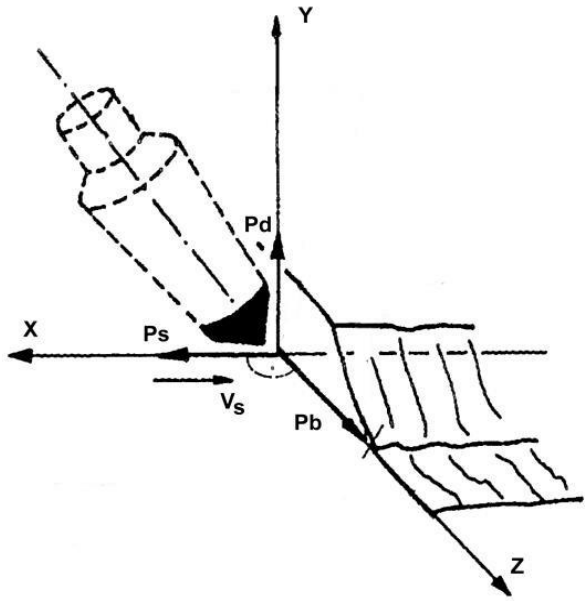
Figure 2. Forces acting on the pick during the cutting process: P s —cutting force (tangent), P d —pressure force (normal) and P b —lateral force [28].